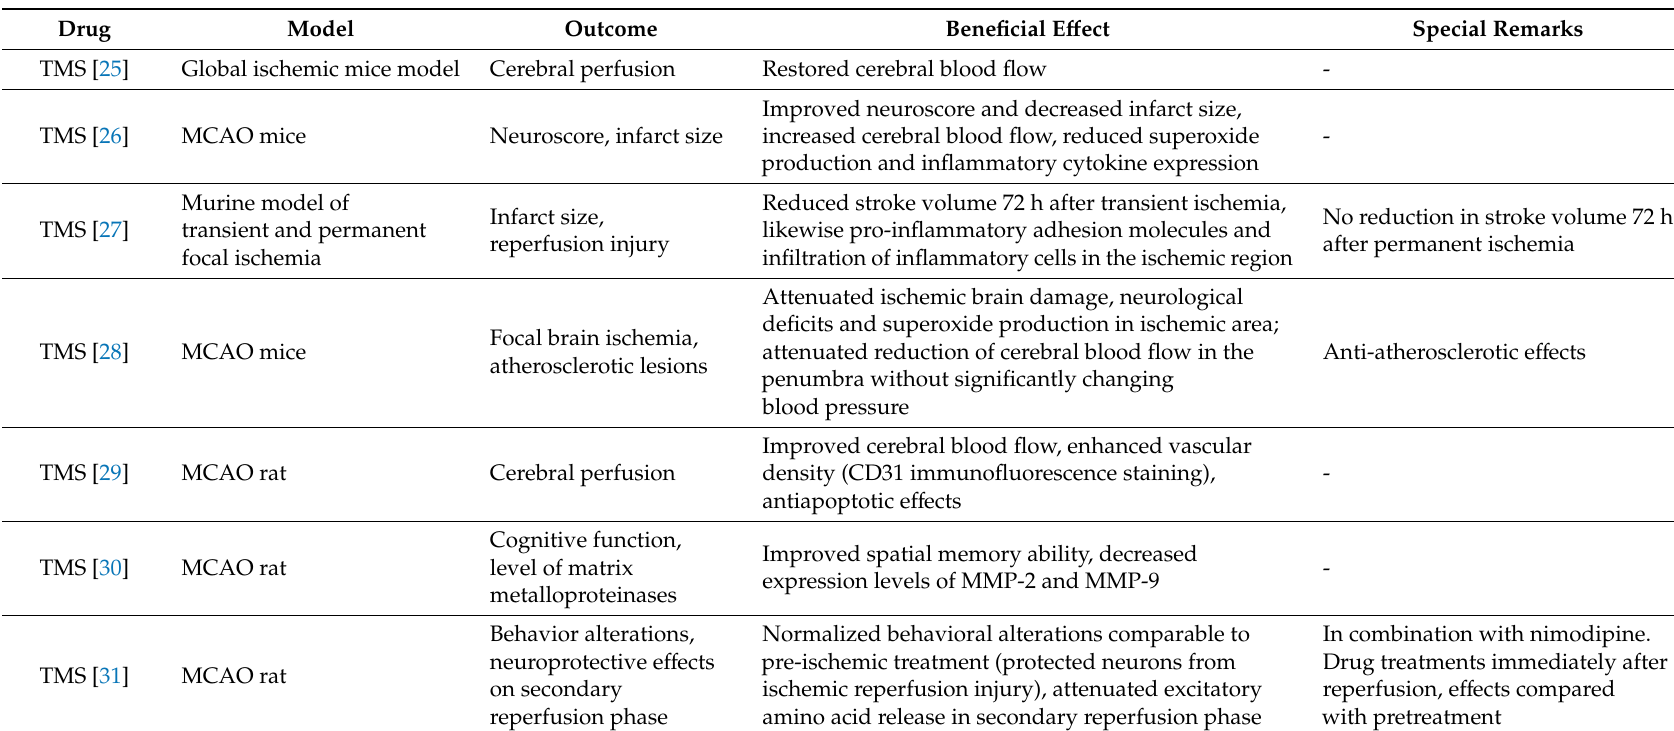
Table 1. Tabular listing of di ff erent preclinical studies showing various e ff ects of Sartan administration (Abbreviations: Angiotensin-II-type-1-receptor (AT 2 -1-R); Angiotensin-II-type-2-receptor (AT 2 -2-R); common carotid artery occlusion (CCAO); chemokine receptor 2 (CCR2); cluster of di ff erentiation (CD); candesartan (CS); desoxy ribonucleic acid (DNA); endothelial nitric oxide synthase (eNOS); endothelin-A-receptor (ET A -R); hours (h); inducible nitric oxide synthase (iNOS); irbesartan (IS); kilogram (kg); losartan (LS); middle cerebral artery occlusion (MCAO); matrix-metallo-proteinase (MMP); messenger ribonucleic acid (mRNA); milligram (mg); minutes (min); n-acetyl-glucosamine oligomer (NAGO); nlr family pyrin domain containing 3 (NLRP3); oxygen glucose deprivation (OGD); olmesartan